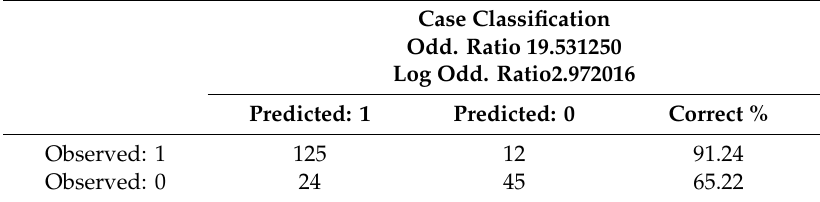
Table 3. The classification matrix for model M.